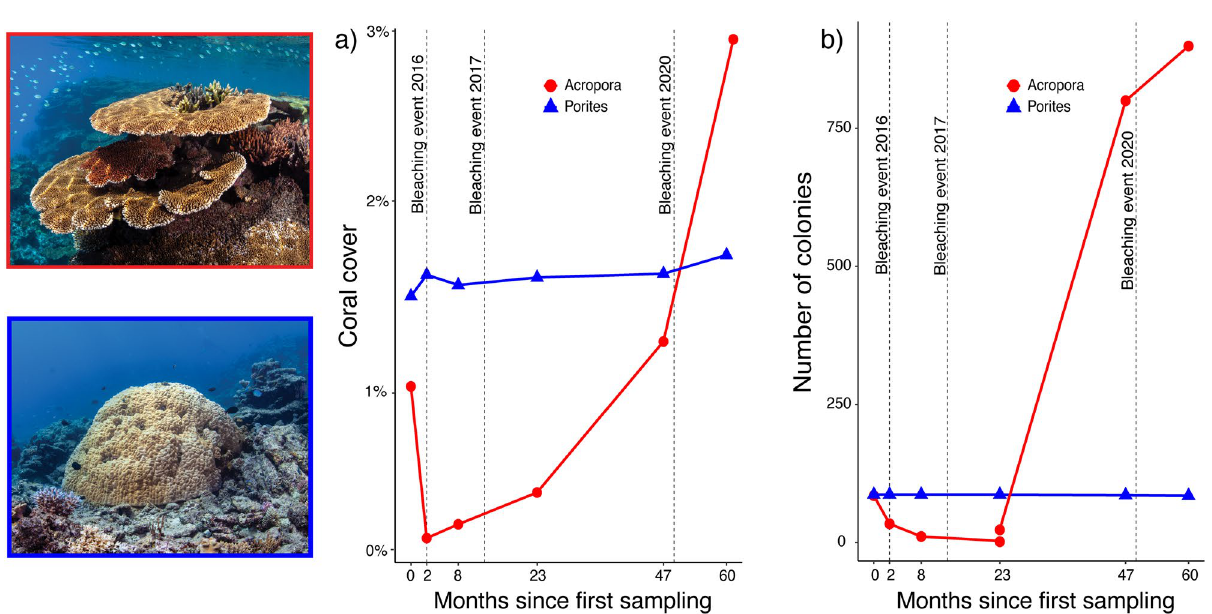
Figure 2. ( a ) Coral cover of Acropora and massive Porites based on 362 quadrats over the 60 month time period. ( b ) Total number of Acropora and massive Porites coral colonies tracked over the 60 month time period spanning three bleaching events at Lizard Island, northern Great Barrier Reef. Photographs: Victor